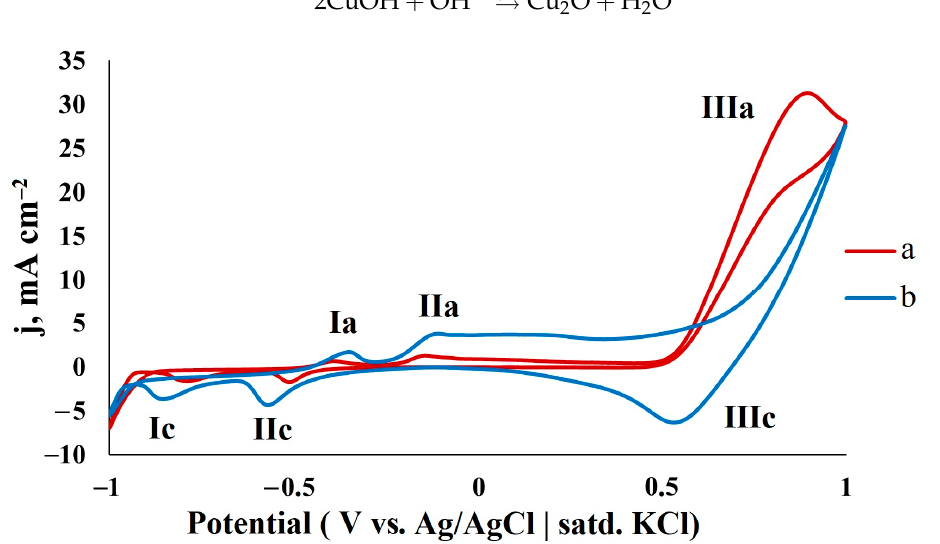
Figure 1. Cyclic voltammograms of the 15th cycle of the modified copper electrode in solution ( a ) without ethanol (0.2 M NaOH) and ( b ) with ethanol (0.1 M NaOH + 0.5 M C 2 H 5 OH). These reactions reflect the process described in Reaction (5). Peak II a indicates Cu/Cu (II) as well as Cu (I) /Cu (II) via electrode processes (11)–(13):